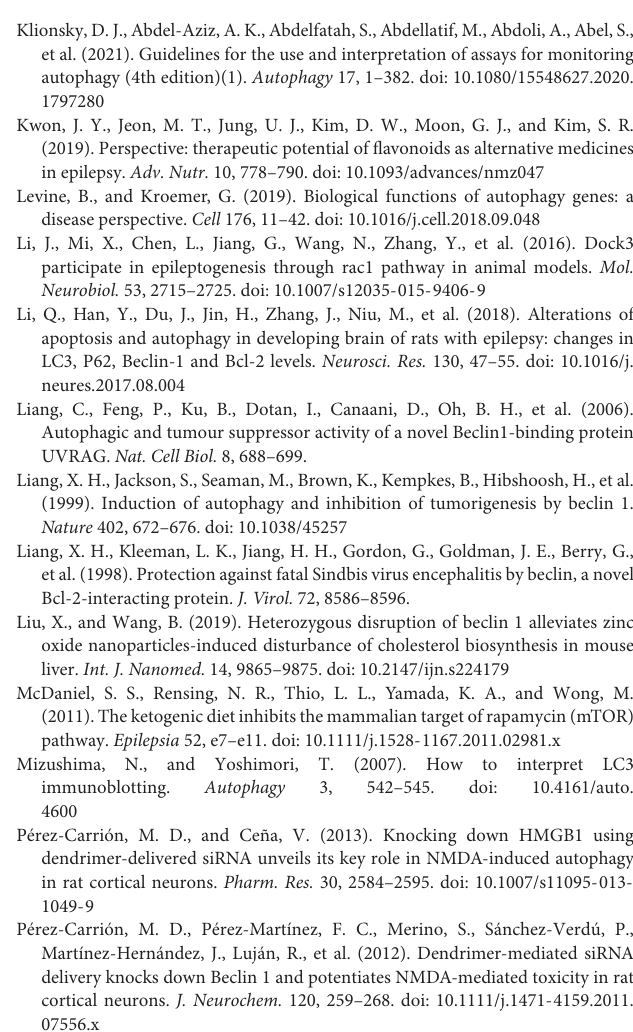
Supplementary Figure 1 | Knockdown of beclin1 altered the intrinsic excitability of neurons. (A,B) Beclin1 protein levels in the cortex and hippocampus of brain tissues from wild-type (WT) and beclin1 ± mice (cortex: n = 5 mice per group; hippocampus: n = 4 mice per group). (C) Paradigm used to record passive excitability in the excitatory neurons. (D) Representative traces of sAPs. (E) Resting membrane potential of the examined neurons from the two groups ( n = 6 per group). (F) Injected currents used to induce the first spikes ( n = 6 per group). (G) Summary of the number of APs induced by the injected currents ( n = 6 per group). Data are presented as the means ± SEM. ∗∗ p < 0.01. Student’s t -tests were